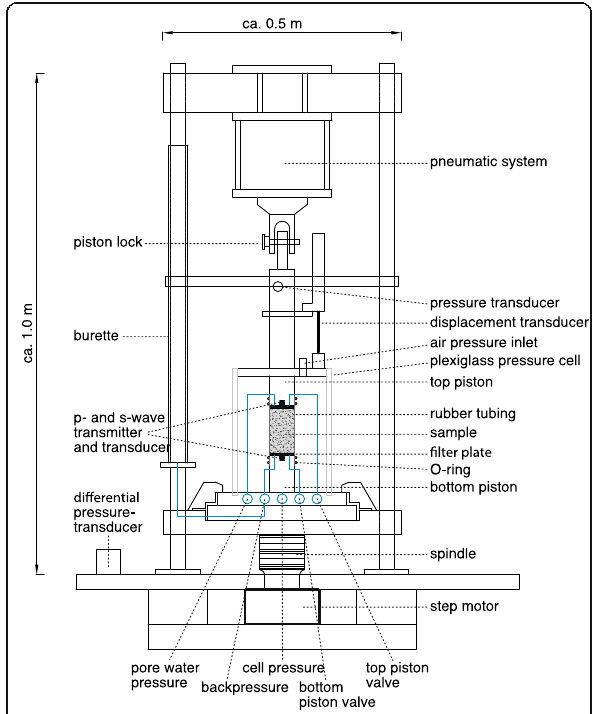
Fig. 3 Schematic sketch of the triaxial deformation apparatus used for compressional testing in the laboratory experiments